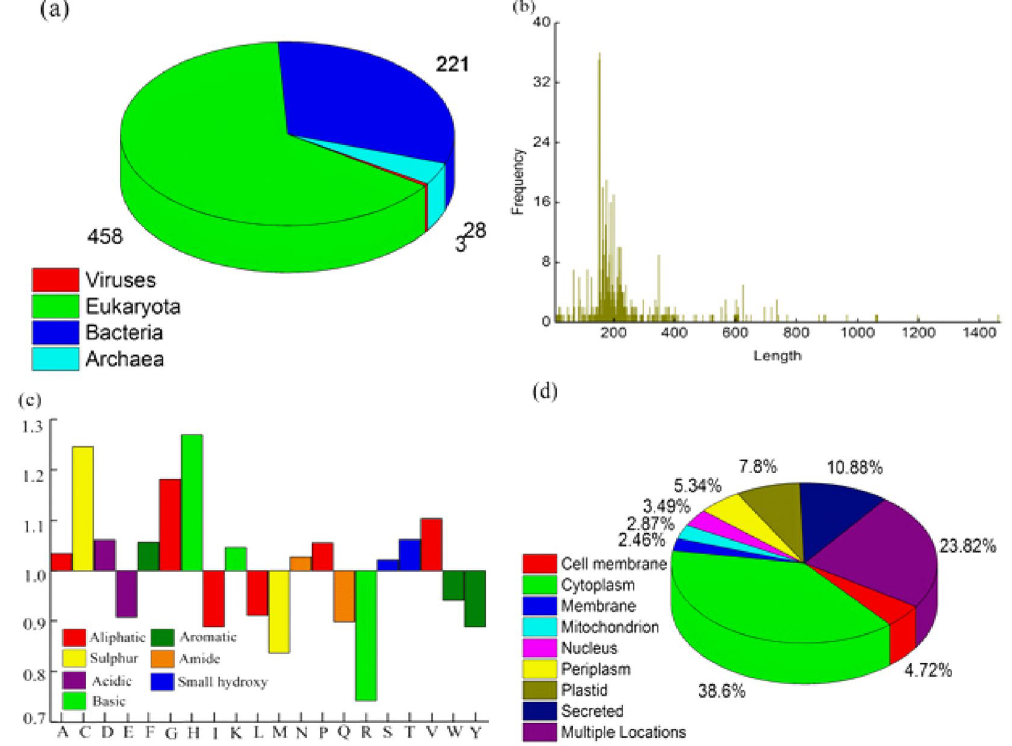
Figure 1. The statistical analysis of AOD. ( a ) Organism distribution of antioxidant proteins in AOD; ( b ) Length distribution of antioxidant proteins in AOD; ( c ) Relative amino acid composition of antioxidant proteins in AOD as compared with Swiss-Prot composition; ( d ) Subcellular location distribution of antioxidant proteins in